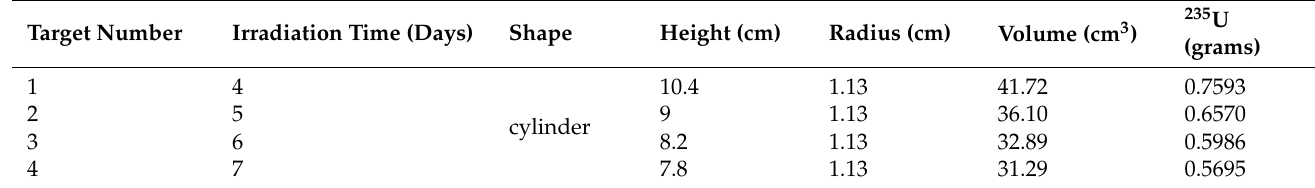
Table 2. Geometry of 4 different targets to produce approximately 9000